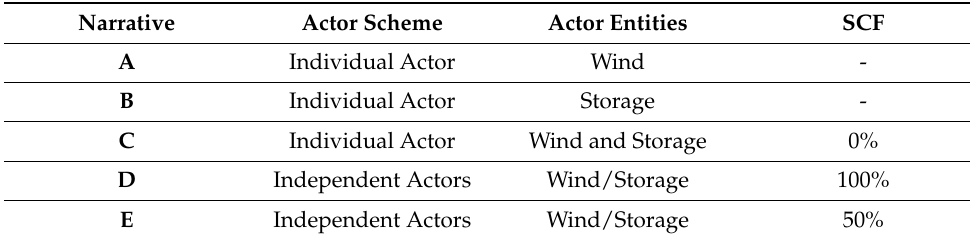
Figure 4. The framework of analysis and scenarios’ matrix. Table 2. Wind–storage narratives examined.